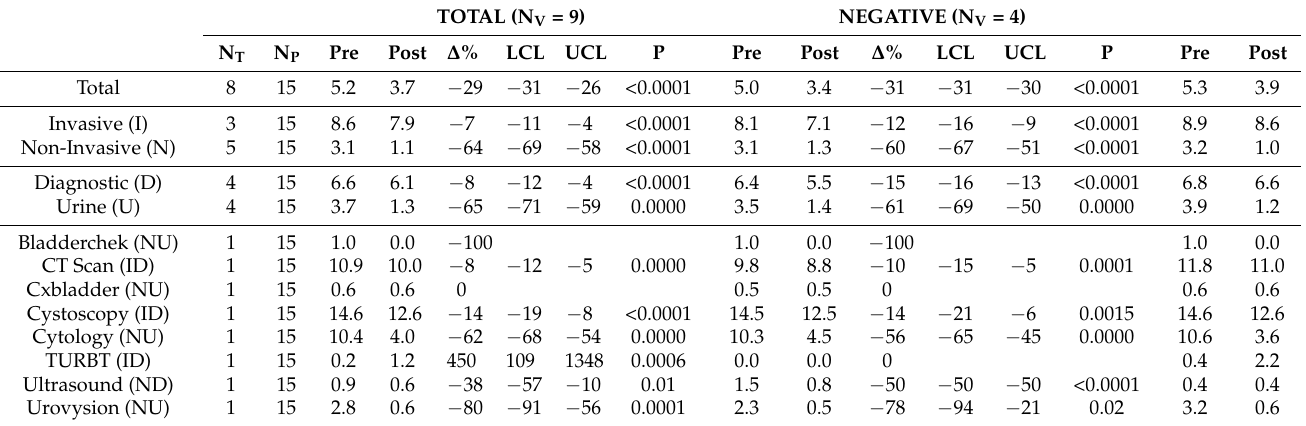
Table 1. Mean absolute and proportional change in the use of diagnostic tests (non-invasive and